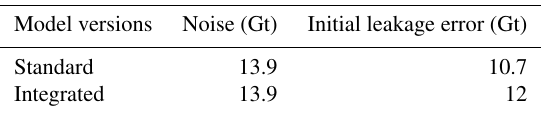
Table 8. Noise and initial leakage error in unscaled GRACE basin- averaged time series of Indus